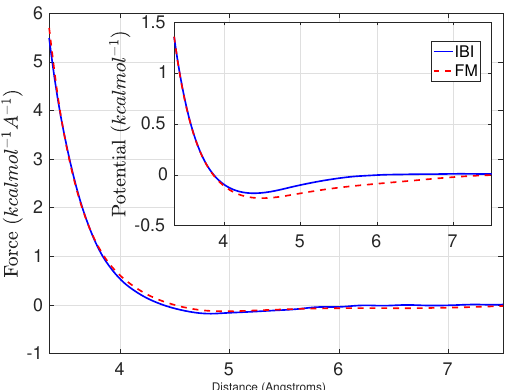
Figure 1. Methane : The effective pair potential for a one-site methane melt, derived with the FM with cubic splines, and the IBI methods, at T = 80 K.